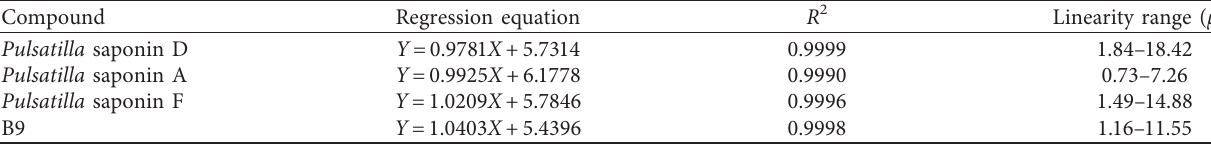
Table 2: Linear regression equation results of 4 kinds of Pulsatilla saponins.